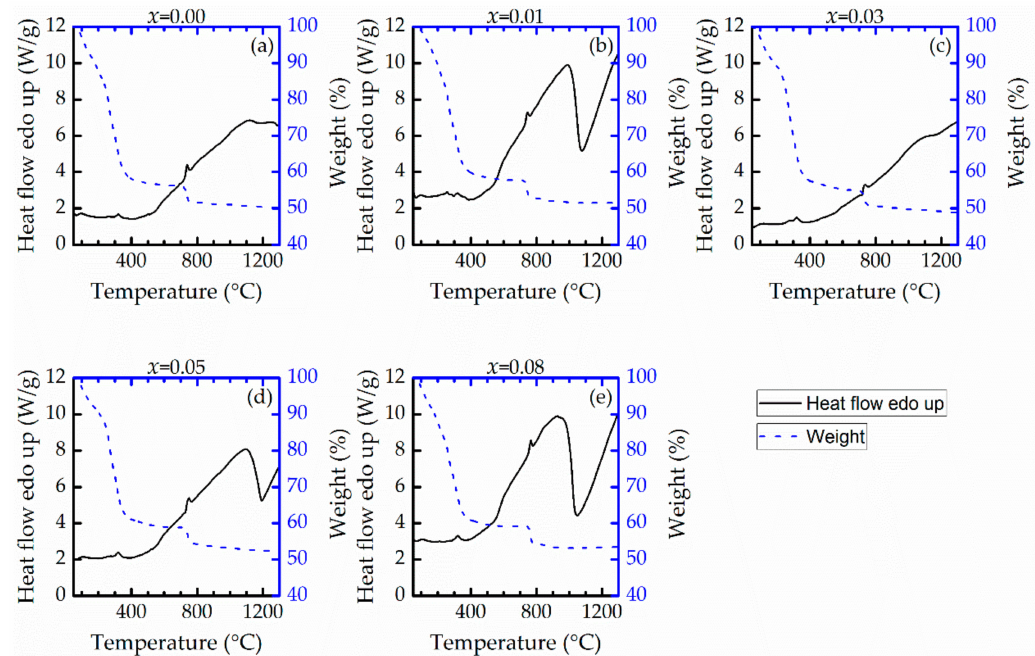
Figure 1. TGA and DTA plots for Ba(Zr x Ti 1 − x )O 3 samples with x composition of ( a ) 0.00, ( b ) 0.01, ( c ) 0.03, ( d ) 0.05 and ( e ) 0.08